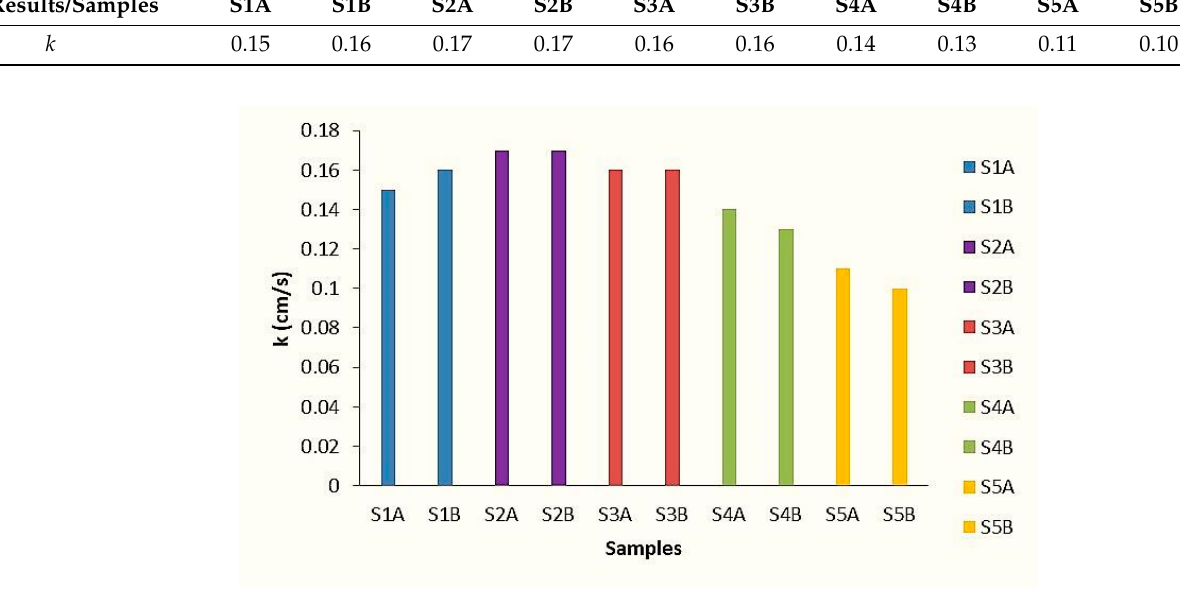
Table 7. Number of cycles of freeze and thaw tests of the tested concrete specimens.